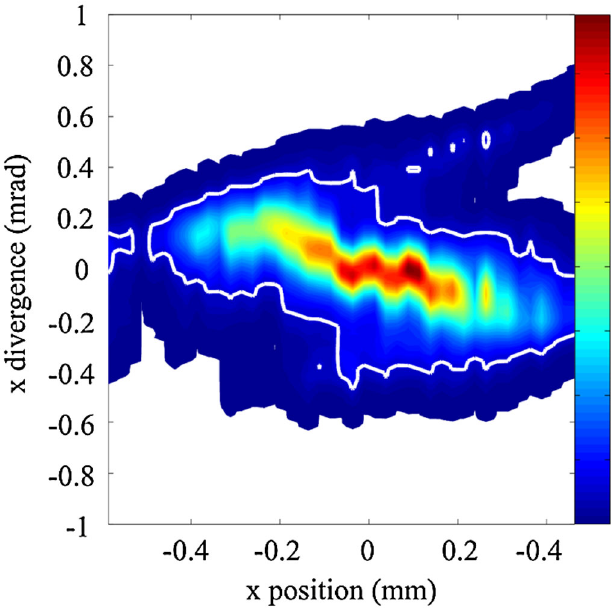
FIG. 37. (Color) Phase-space distribution at an electron beam mean momentum of 14 : 45 MeV =c , main solenoid current 373 A, and with the phases of gun and booster at maximum mean momentum gain. The white contour surrounds the phase-space area that remains after a 10% charge cut has been applied (see text).FIG. 36. (Color) Minimum of the emittance as a function of the